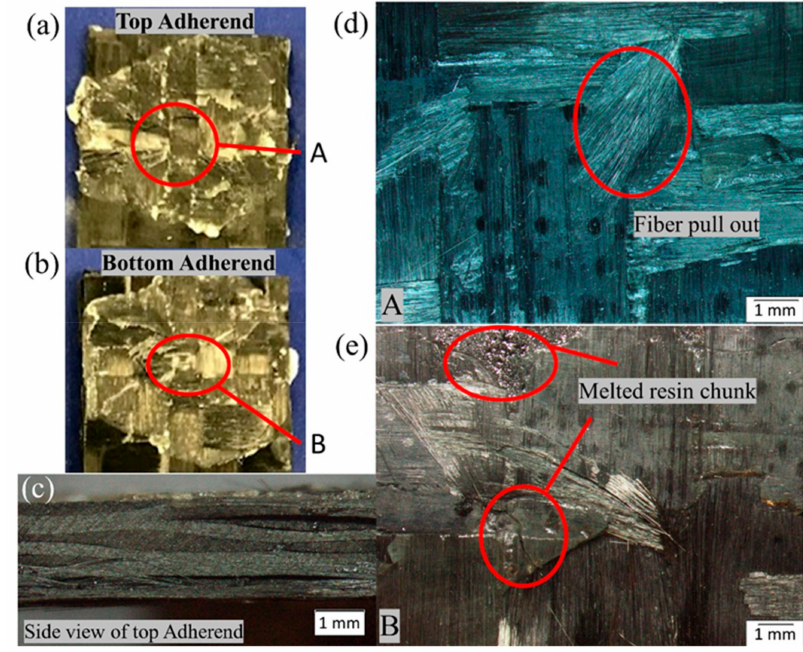
Figure 14. Fracture surfaces of SC-ELC_FL-ELC specimen with maximum LSS